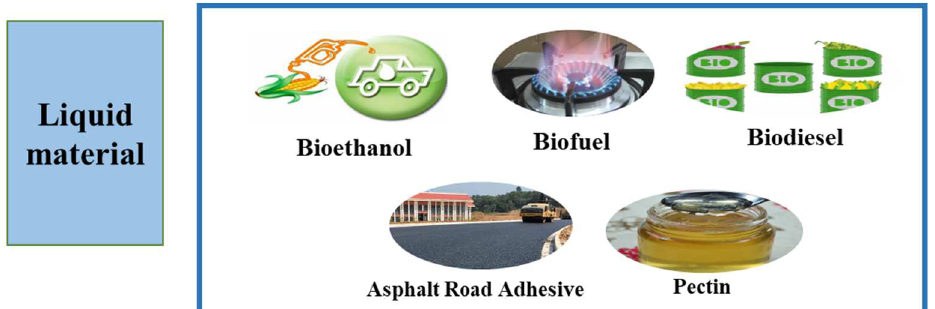
Figure 7. Applications of liquid material obtained by hydrothermal treatment of food waste.